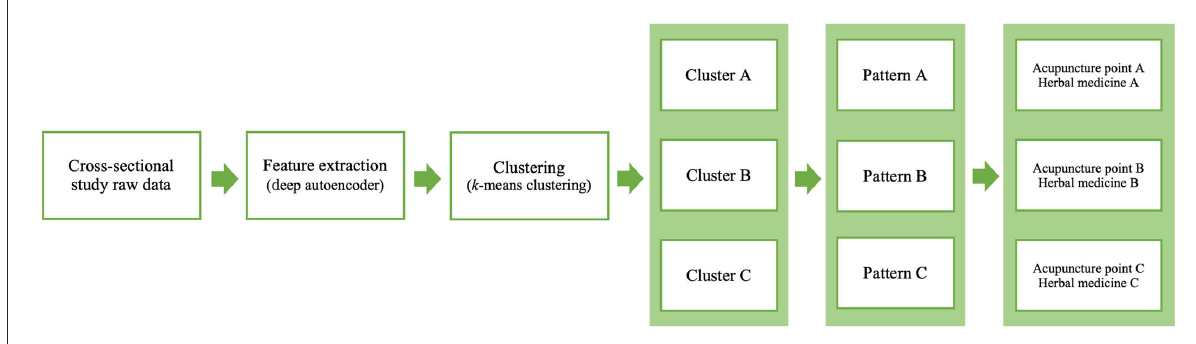
FIGURE8 Flow diagram of the proposed PI model for acupuncture point and herbal medicine